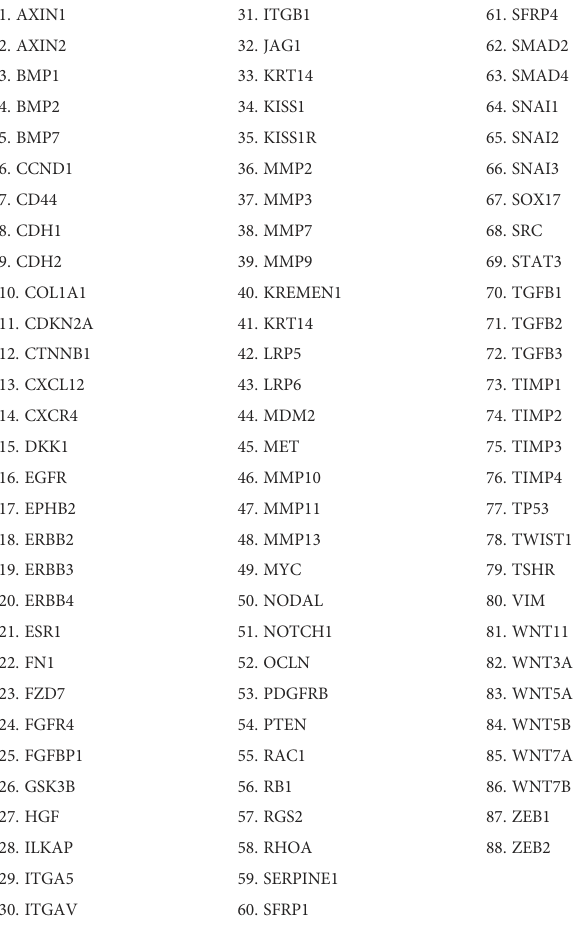
TABLE 4 List of 88 genes target of Prime PCR card of epithelial- mesenchymal transition, stemness and metastagenesis panel. 88 target